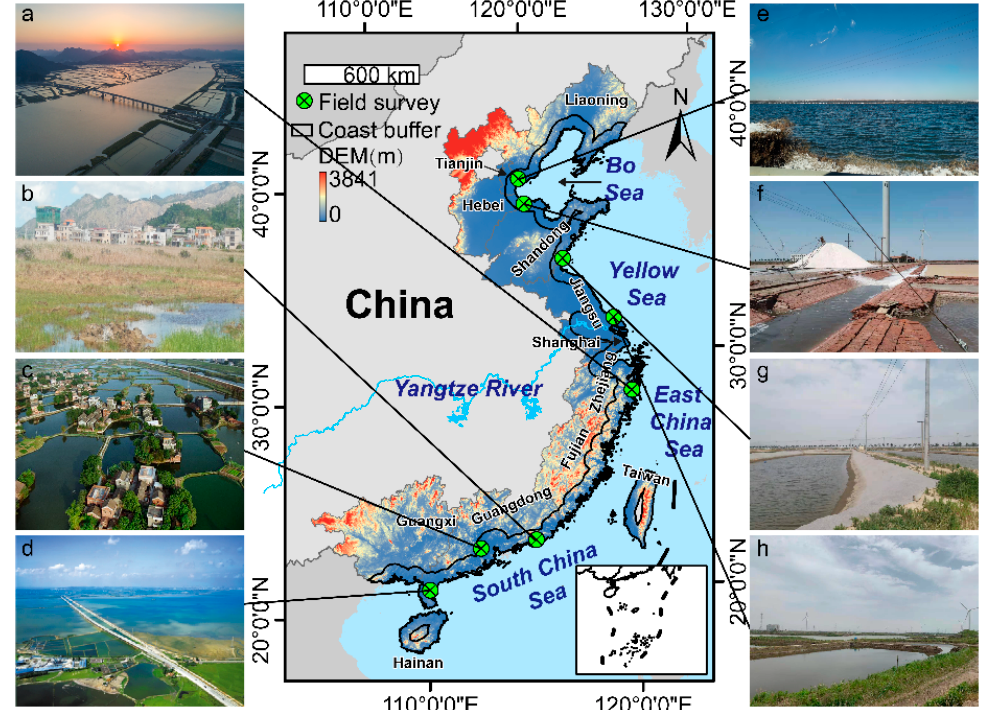
Figure 1. Regions of interest, eight field survey areas within 50 km along the coastline: ( a – d ) are located south of the Yangtze River; ( e – h ) are located north of the Yangtze River. Photo source: site survey shooting ( b , e – h ) and internet photo (( a ): http://n.sinaimg.cn/sinacn/w600h337/20171 208/6cb7-fypnsip0995062.jpg, accessed on 14 July 2021, ( c ):